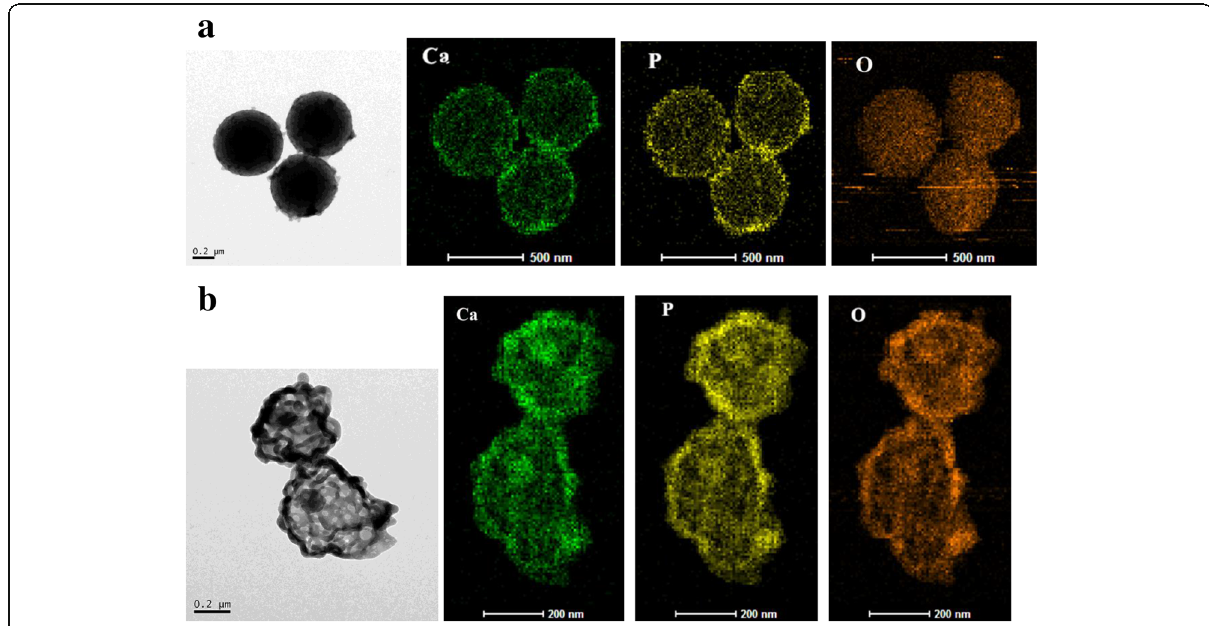
Fig. 4 The element mapping of yolk @ cage-shell hollow ACP sphere before calcination ( a ) and after calcination ( b )